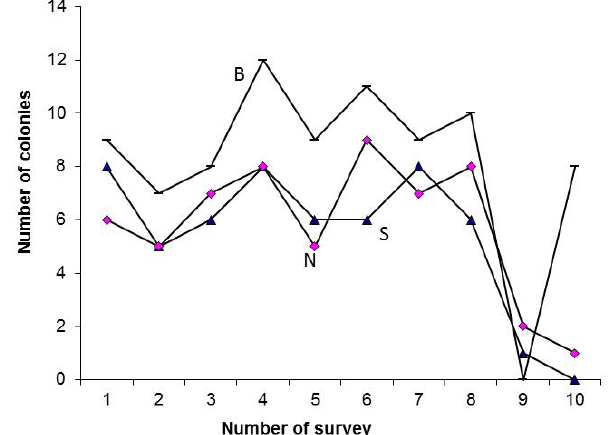
Numbers of colonies of Mischocyttarus cerberus (B), M. cassununga (N) and Polistes satan (S) attached to the house in the study